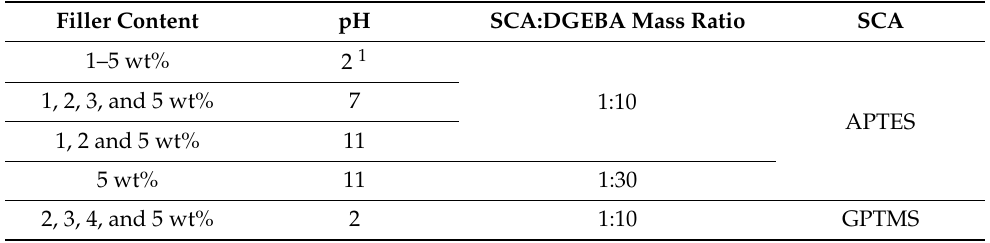
Table 1. Compositions of the epoxy-SiO 2 nanocomposites prepared via the in situ sol–gel method. Filler